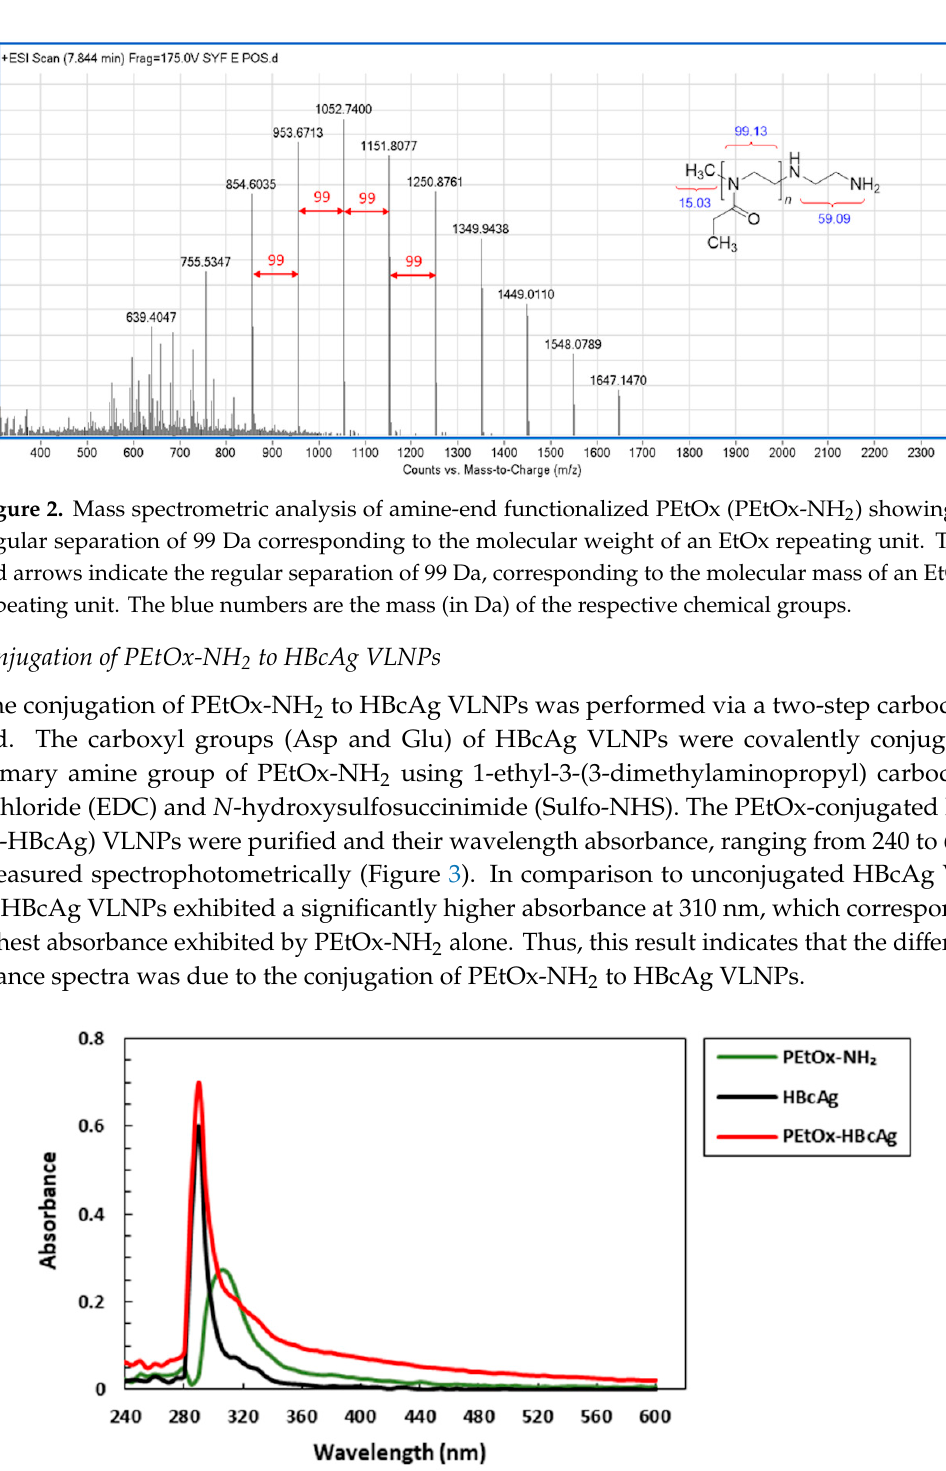
Figure 3. UV-visible spectra of the conjugation of PEtOx-NH 2 to hepatitis B core antigen (HBcAg) virus-like nanoparticles (VLNPs). UV-visible measurements of HBcAg VLNPs (0.7 mg / mL), PEtOx (0.7 mg / mL), and PEtOx-HBcAg VLNPs (0.7 mg / mL) were determined using a spectrophotometer. The absorbance at wavelengths ranging from 240 to 600 nm was measured at room temperature.